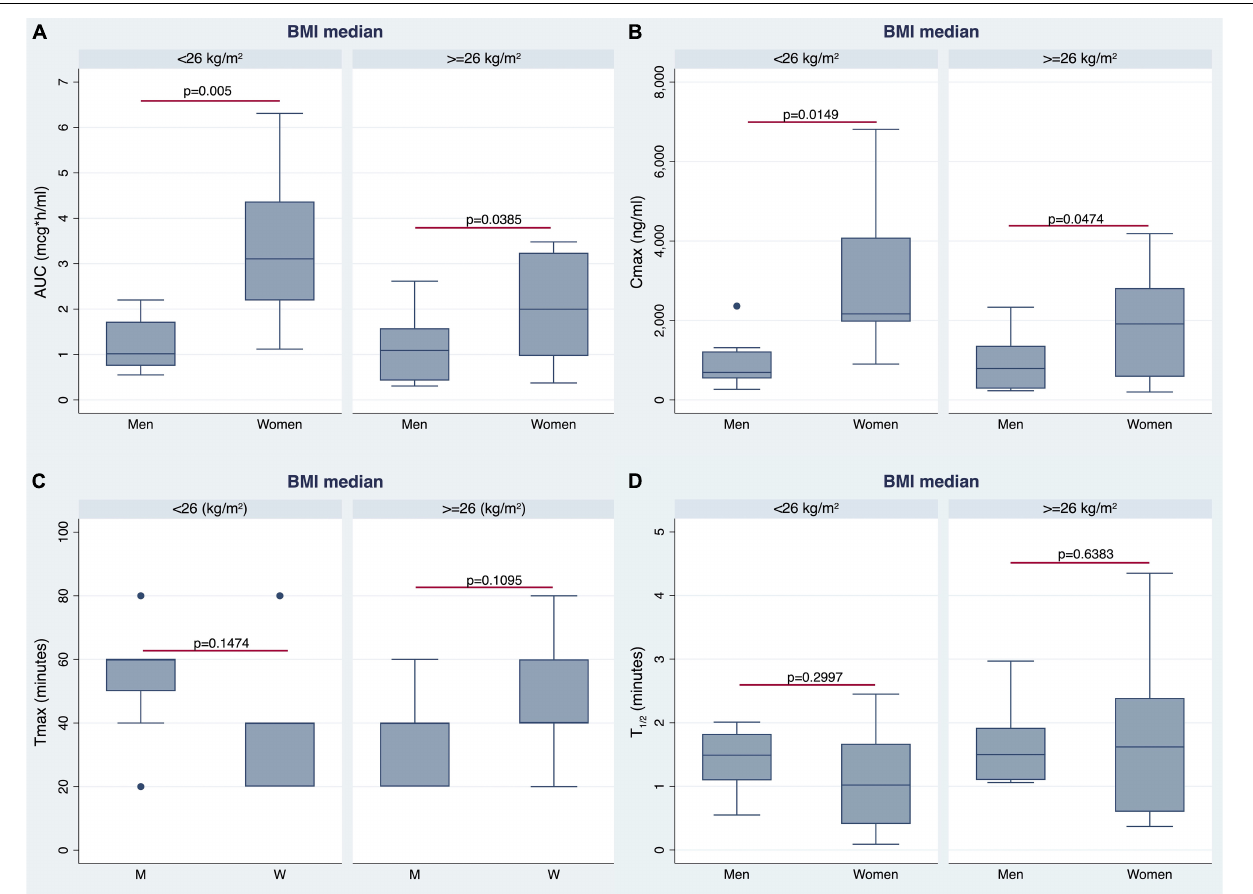
FIGURE 6 | Gender differences observed in AUC (A) , Cmax (B) , time to reach Cmax (Tmax) (C) , and t 1 / 2 (D) by stratifying the study population according to median BMI